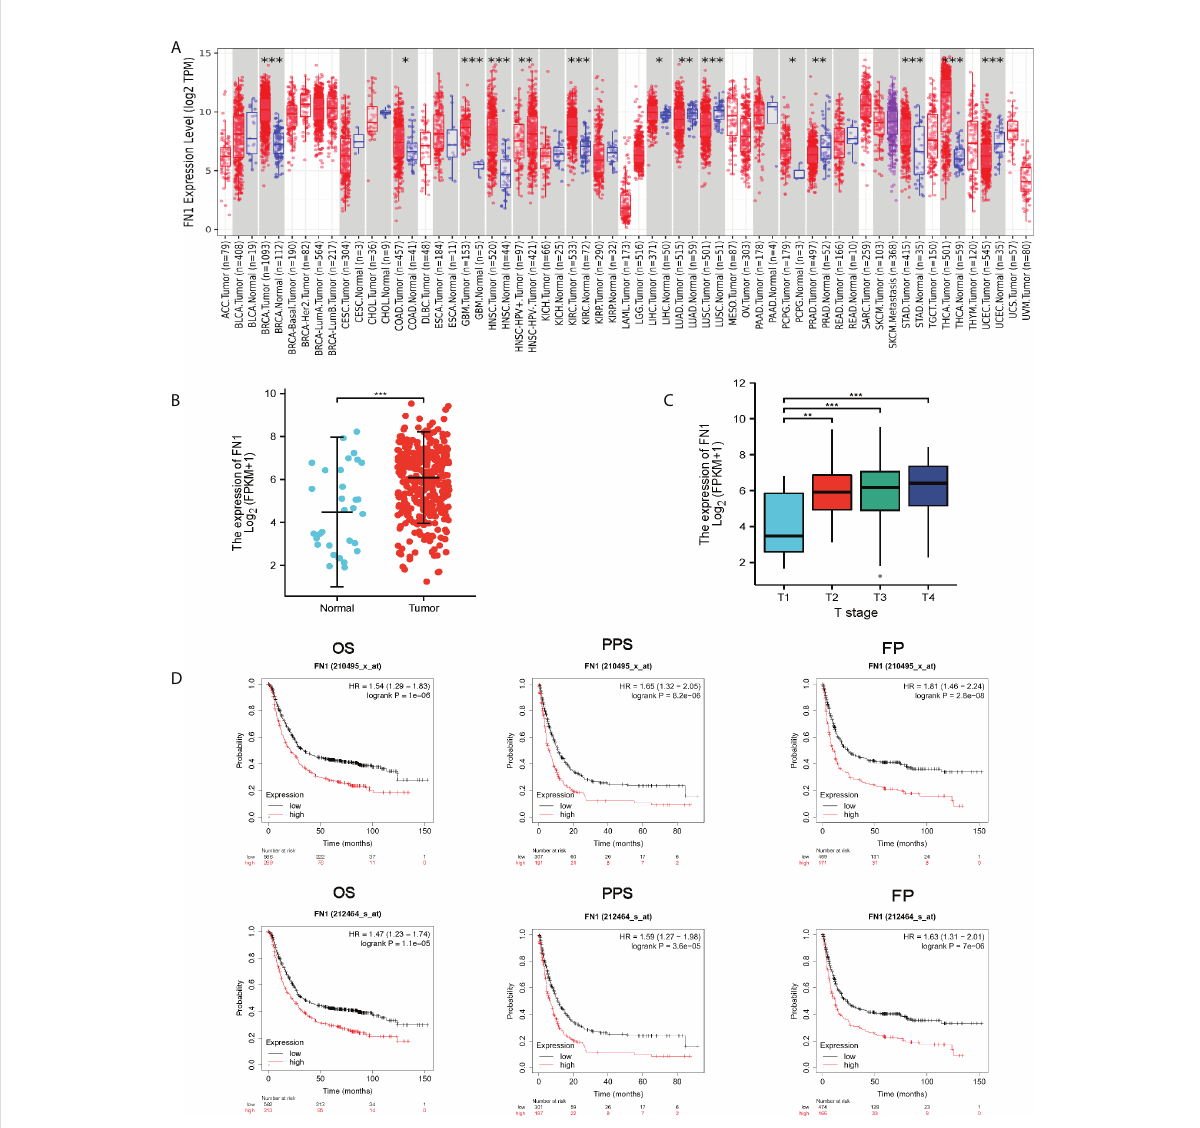
FIGURE 1 FN1 expression levels in different types of human cancers. (A) Human FN1 expression levels in different tumor types from TCGA database were determined by TIMER (*p < 0.05, **p < 0.01, ***p < 0.001). (B) FN1 mRNA expression in STAD tissues and normal tissues (N = 32; T = 375). (C) Association of FN1 expression with T stage. (D) OS, FP, and PPS survival curves of gastric cancer. OS, overall survival; FP, fi rst progression; DFS, Disease free